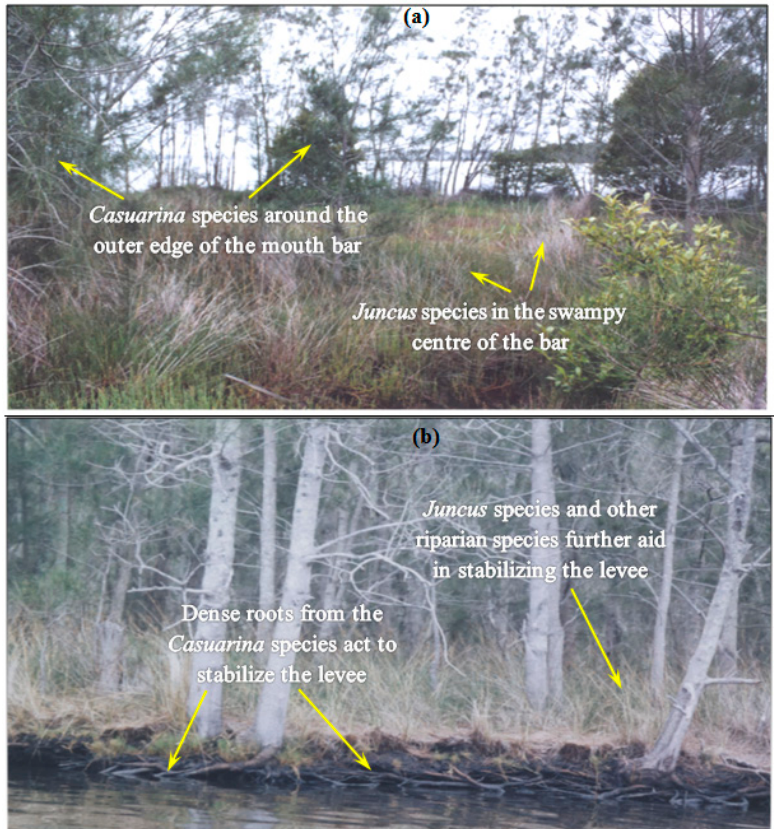
Figure 7. Vegetation canopy acting positively to assist the geomorphic growth and to develop the deltaic ecosystem; ( a ) Casuarina has vegetated the outer edge of the subaerial portion of the mouth bar whereas the depressed swampy portion in the centre of the bar is dominated by Juncus . ( b ) Casuarina and Juncus stabilising and expediting vertical accretion of the subaerial portions of the Wandandian Creek delta (levees and mouth bars; after [15]).